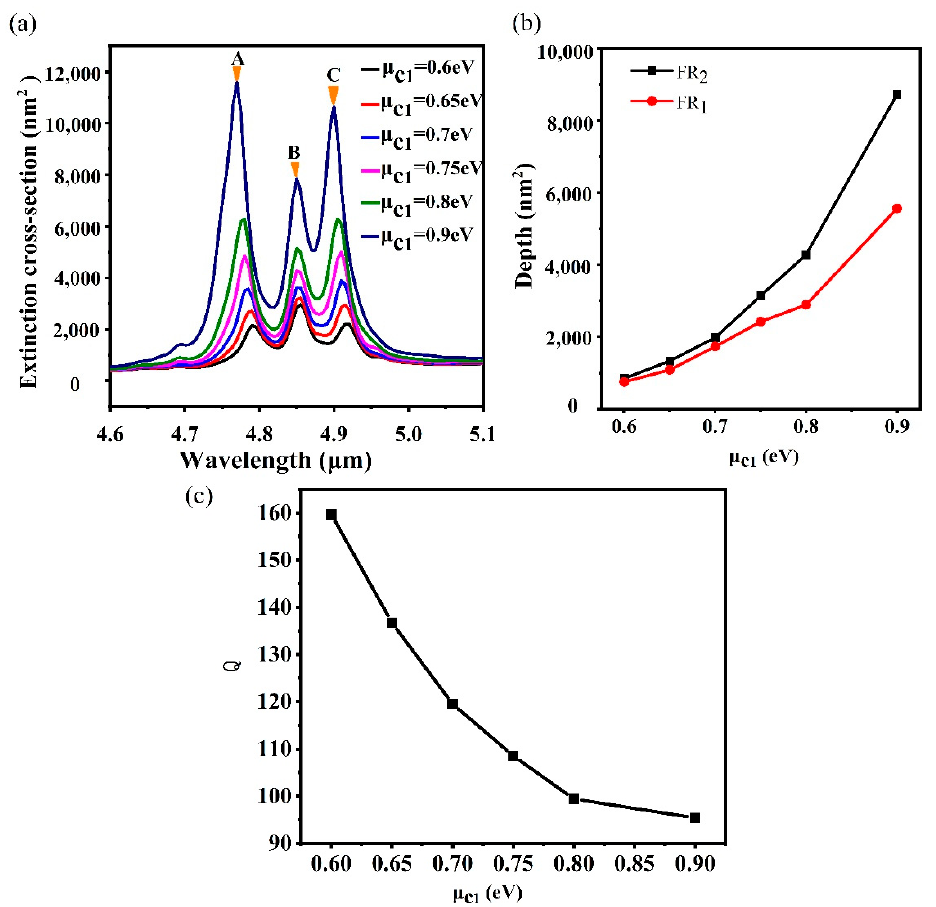
Figure 5. ( a ) Extinction spectra with the increase of the chemical potential of the central nanodisc. ( b ) Modulation depth of two FR modes with the variation of µ c 1 . ( c ) The Q factor of the FR 2 mode with the variation of µ c 1 .